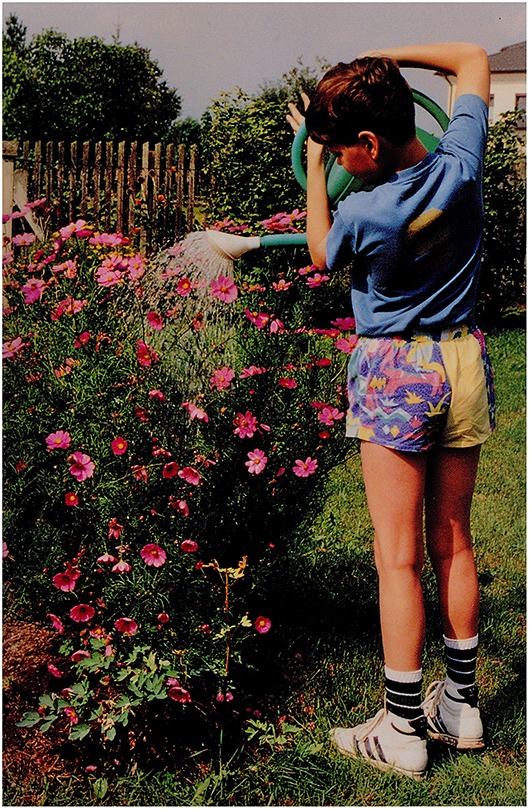
A boy is watering flowers (Stark, 1998).